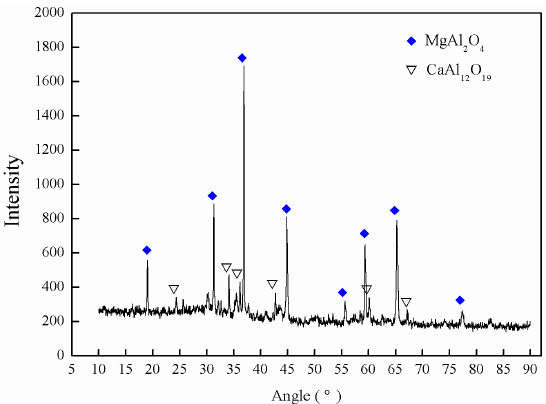
Figure 1. X-ray diffraction (XRD) pattern of the accretion collected from the submerged entry nozzle (SEN).